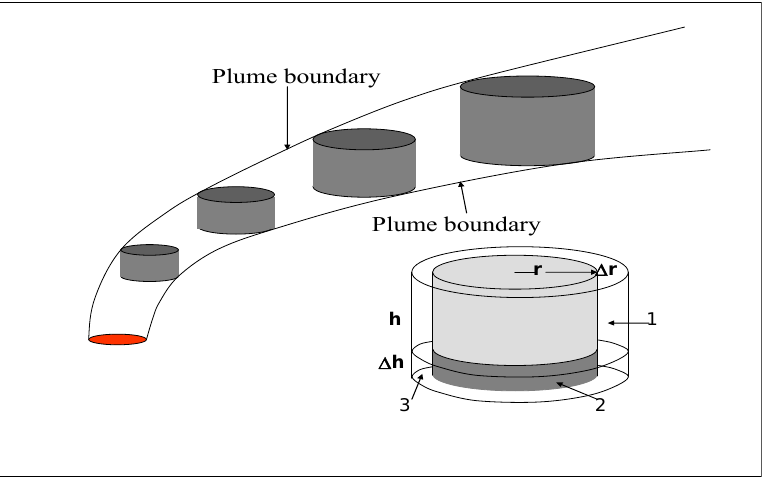
Figure 3. A schematic showing the boundaries of a smoke plume defined by rising, entraining turrets. Inset: three components of an expanding cylinder: ( 1 ) an annulus around the original cylinder; ( 2 ) a cylinder added to the original cylinder; and ( 3 ) an annulus around the added